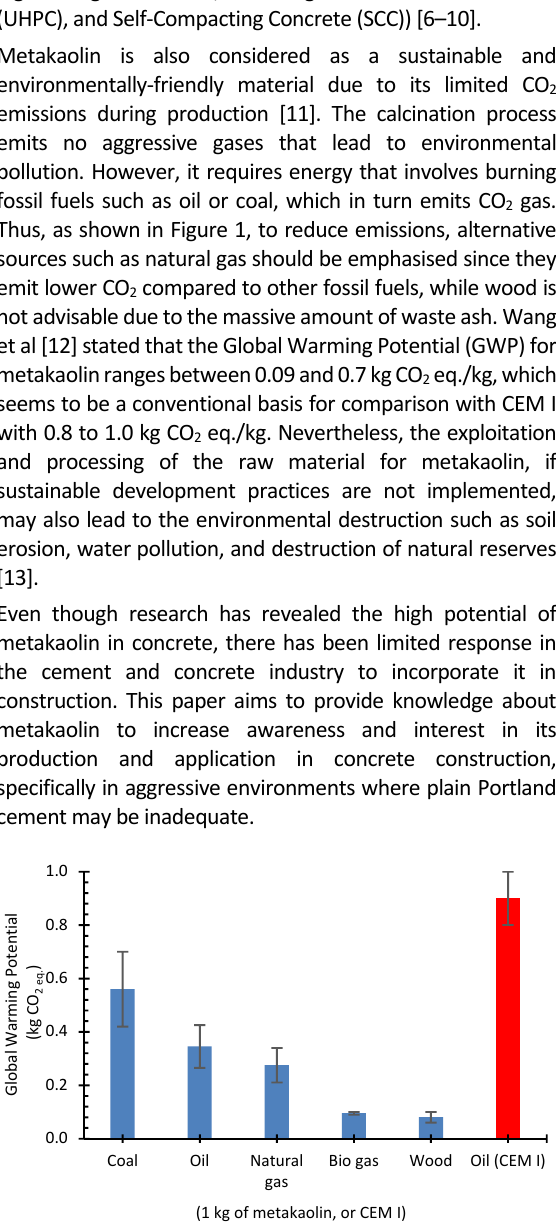
Figure 1. Global Warming Potential in kg CO 2 eq to produce 1 kg of metakaolin depending on the type of fuel used for calcination [14] in comparison to CEM I